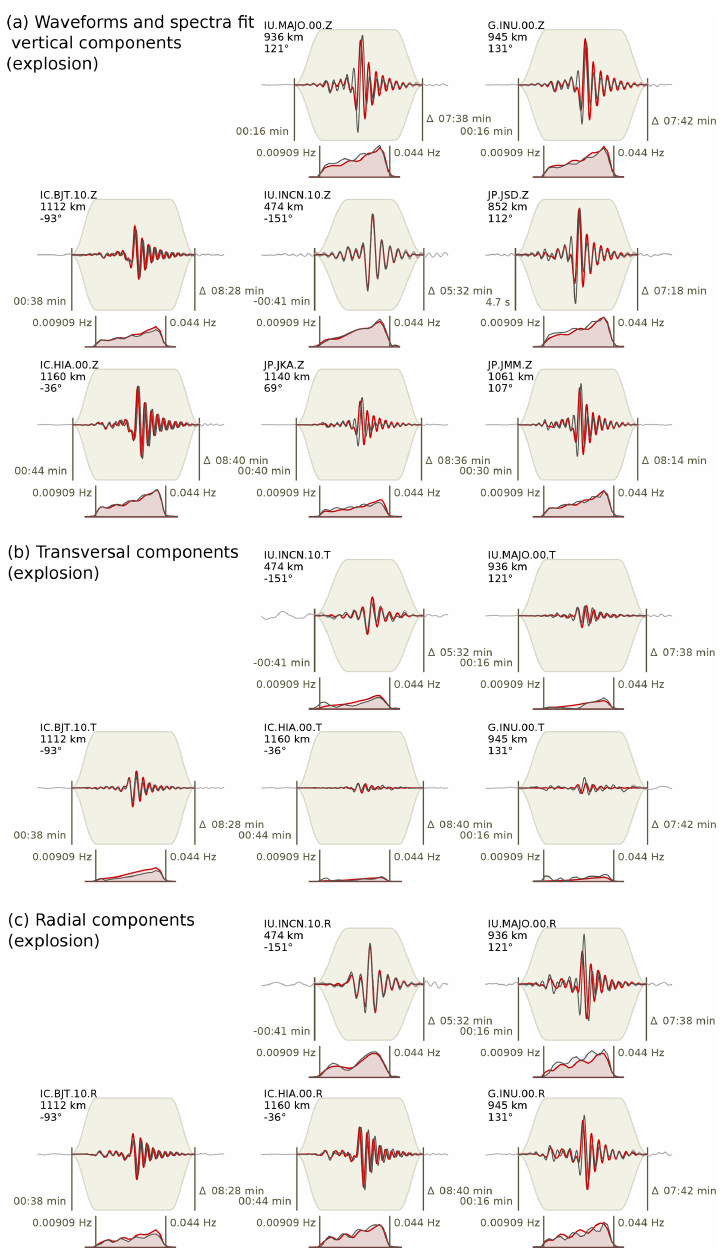
Figure 5. Full waveform displacement and amplitude spectra fits (gray and red lines denote observations and synthetics, respectively) are shown for the nuclear explosion for the vertical (a) , transversal (b) , and radial components (c) . The top left side of each plot reports the trace component (network, station, location, and component codes), epicentral distance, and azimuth. Waveform plots report the starting time (relative to the origin time) and duration (in minutes and seconds) of the time window used (the gray background represents the applied taper), while spectra plots report the frequency range in Hz. For geographical locations of the stations used, see Fig.